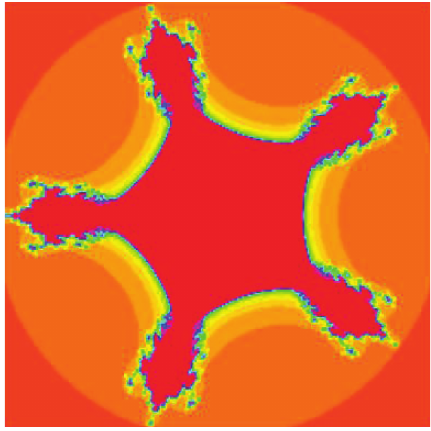
Figure 13: Relative superior multicorn for 𝑠 = 1.0 and 𝑠 󸀠 = 1.0 .